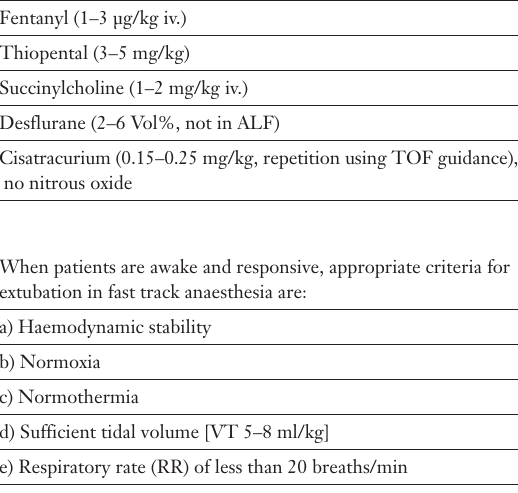
Current protocol for fast track anaesthesia in OLT, Charité – University Medical Centre, Berlin.